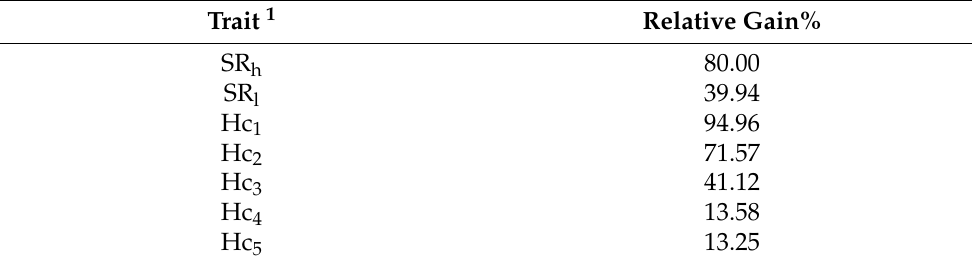
Table 10. Relative gain in the true selection response when a fraction of the population was genotyped for scrapie ( n = 20,000) relative to the response when the whole population ( n = 1,671,890) was genotyped.